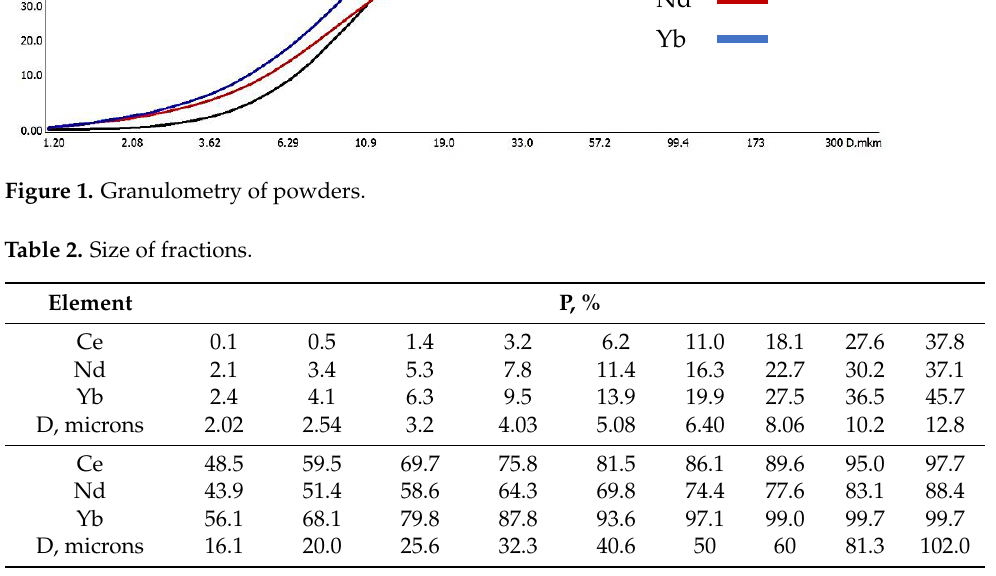
Table 3. Parameters of sediment carbonation of